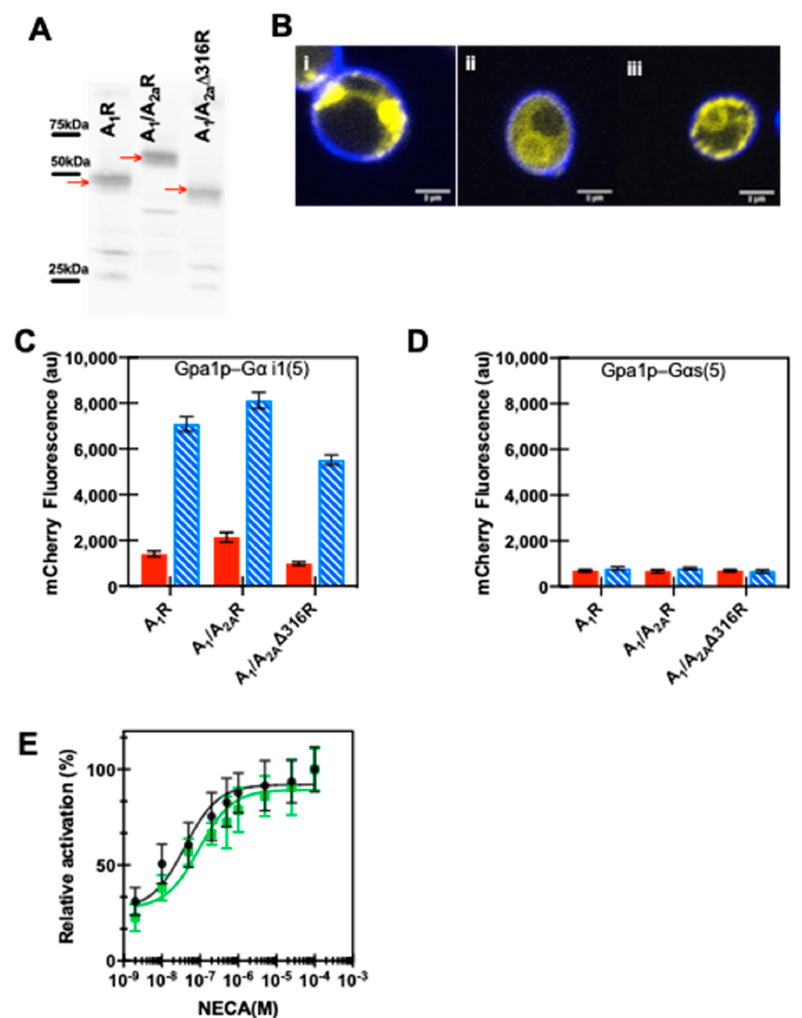
Figure 6. Expression and downstream MAPK signaling response in yeast for A 1 / A 2A R and A 1 / A 2A ∆ 316R chimeras show native A 1 R-like behavior. ( A ) Western blot images showing expression of mCitrine tagged receptors for full-length and truncated chimeric receptors. Precision Plus Protein Western C standards were used to determine molecular weight as indicated. The expected molecular weight of each receptor with mCitrine is as follows: A 1 R, 63.4 kDa; A 1 / A 2A R-71.5 kDa and A 1 / A 2A ∆ 316R-62.3 kDa. Note that the mobilities are slightly faster than that expected by calculated molecular weight; membrane proteins have been found to run faster than expected, possibly due to their hydrophobicity or incomplete denaturation, due to the absence of sample heating [88]. ( B )RepresentativeconfocalimagesofyeaststrainsshowingreceptorlocalizationofA 1 R(i), andA 1 / A 2A R (ii) and A 1 / A 2A ∆ 316R (iii). Cells were stained with fluorescent brightener calcofluor white M2R (F3543; Sigma-Aldrich) that binds to chitin in the yeast cell wall prior to imaging, and this stain is shown in blue, while mCitrine fluorescence is shown in yellow. Scale bar = 2 µ m. ( C , D ) Downstream signaling response of receptor variants in inhibitory Gpa1p-G α i1(5) ( C ) or stimulatory Gpa1p-G α s(5) strain ( D ). A 1 / A 2A R and A 1 / A 2A ∆ 316R produce signaling response similar to A 1 R in inhibitory strain; however, none of the receptors produce a response in stimulatory strain. 100 µ M NECA is shown as blue hatched bars and DMSO in red filled bars. ( E ) Dose-response curve for A 1 / A 2A R chimera (green squares) is similar to the native A 1 R receptor (black circles). Data represent the mean ± 95% C.I. for experiments performed in duplicate for three independent